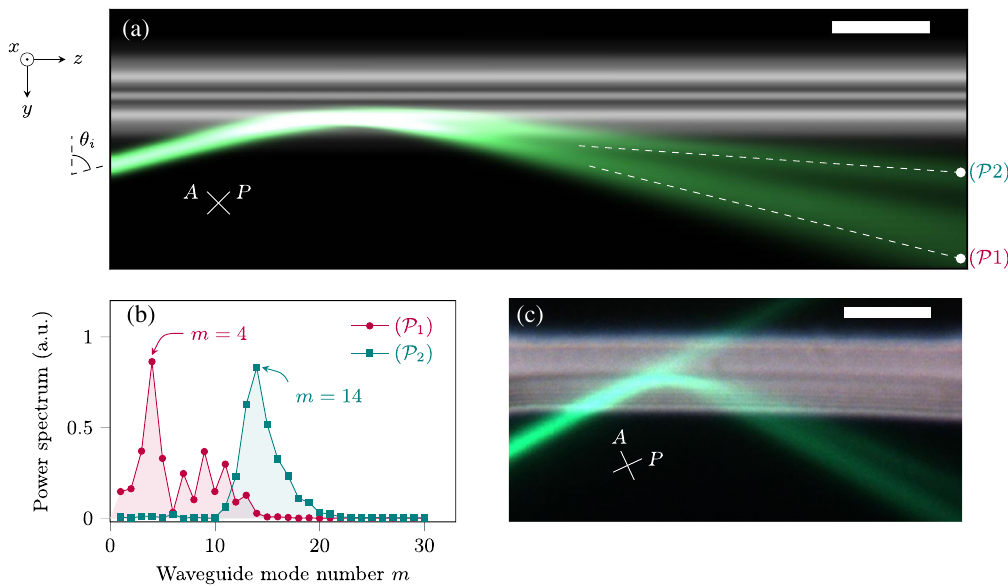
FIG. 6. (a) Simulated microscope images of an extraordinary beam reflected by a twist wall in a thin sample of 10 μ m. The incidence 75 °. Similar to Fig. 4, the simulated birefringent-medium twist wall is observed under crossed polarizers, and the green part angle is θ i ¼ of this image is obtained by averaging along x the three-dimensional optical field intensity simulated with BPM. The white bar represents 10 μ m. (b) Calculated power spectrum at points P 1 and P 2 in (a) as a function of the waveguide mode number. The dominant waveguide mode numbers for P 1 and P 2 are used to predict the main directions of propagation of reflected modes [dashed white lines in (a)] using Eq. (12). (c) Experimental images in a thick sample of 40 μ m showing a splitting of reflected modes consistent with those in (a). The white bar is 100 μ